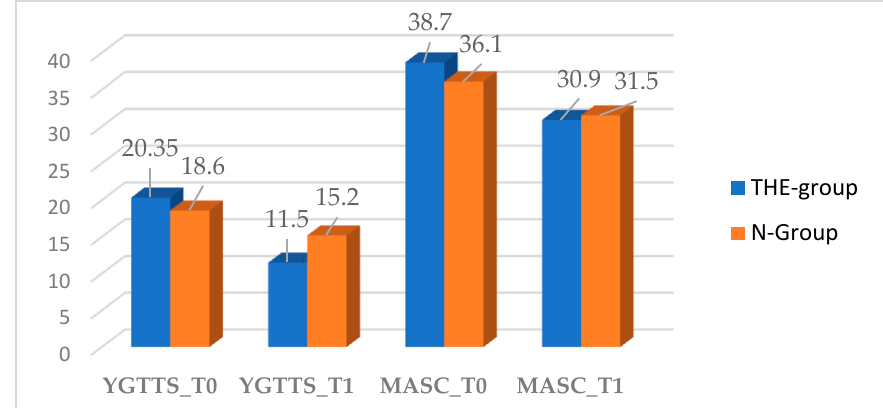
Figure 1. YGTSS and MASC scores between clinical groups.